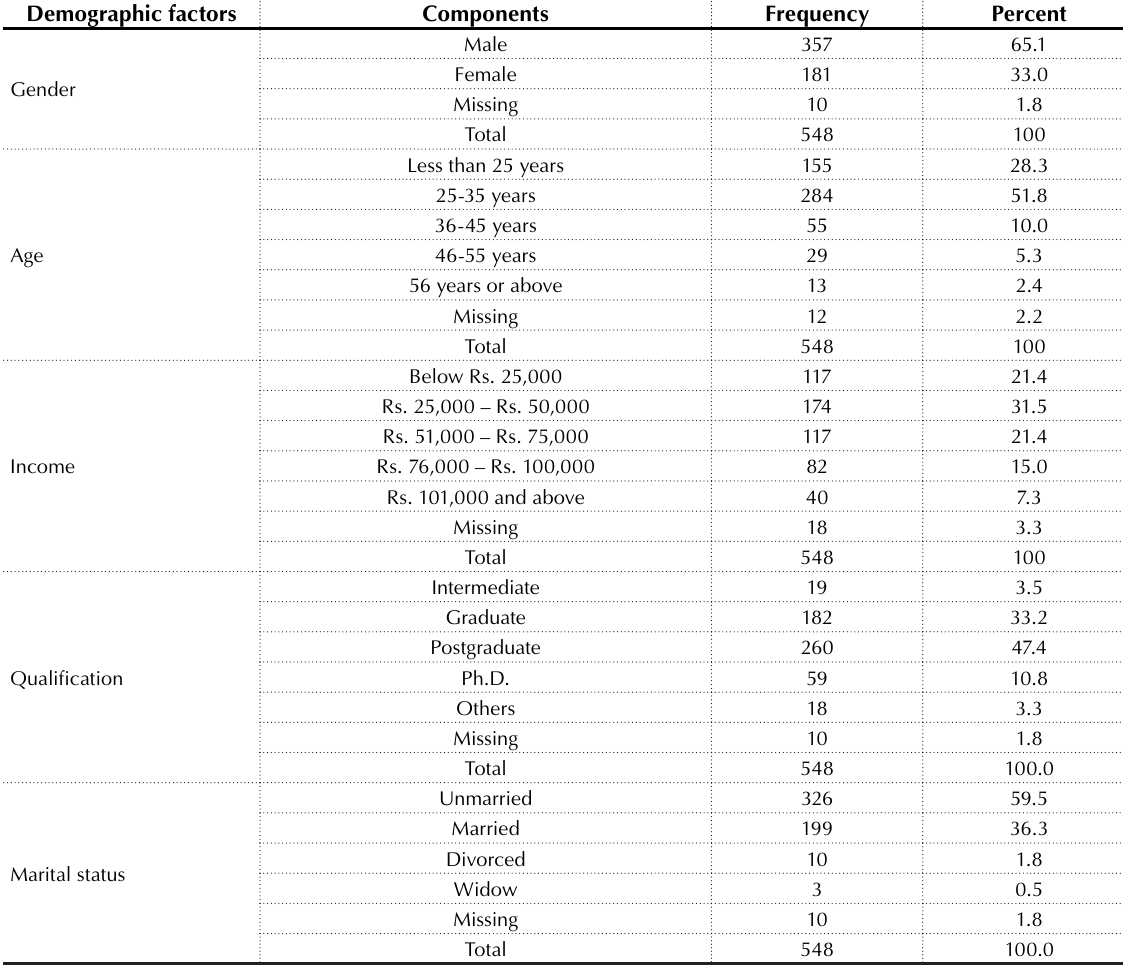
Table 1. Demographic profile of the respondents Demographic